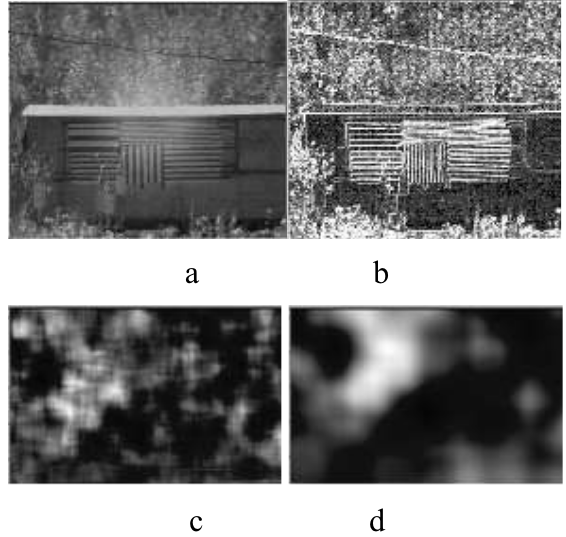
Fig. 3. Object image (a), its sharpness functional (b) and quality maps (c-d). The horizontal size of the region observed is 5 m; a t =5 cm, the distance t = 10 z obj =500 m, and Δ